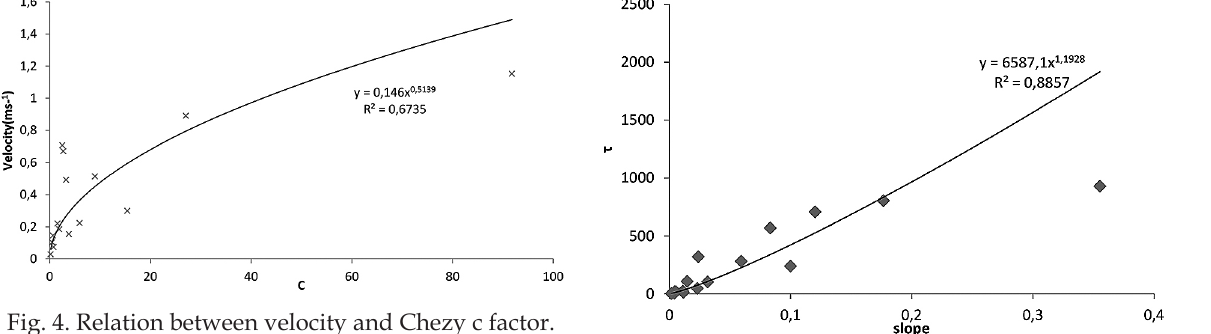
Fig. 4. Relation between velocity and Chezy c factor.